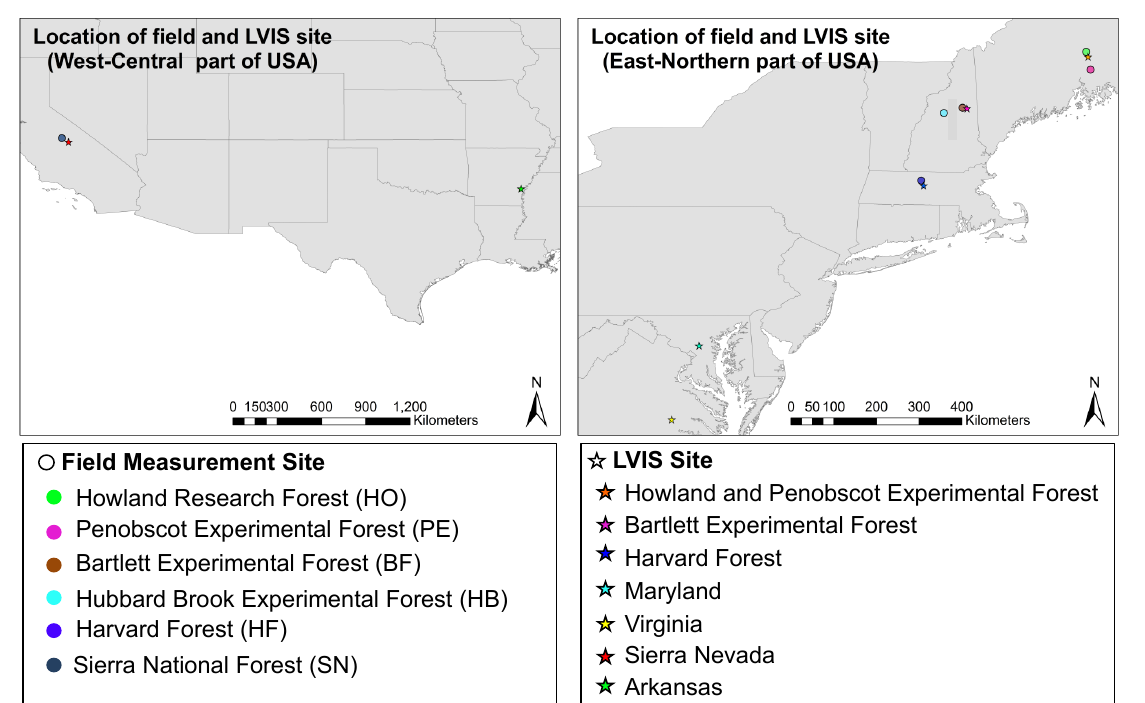
Figure 1. Geographical locations of field measurements and LVIS